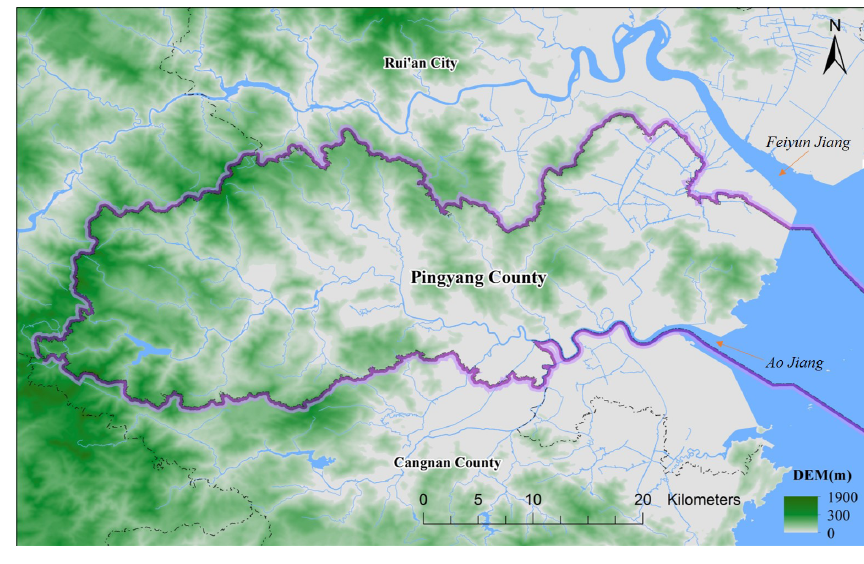
Figure 1. Case study area. Table 1. Multisource data used to perform storm surge numerical modeling in Pingyang